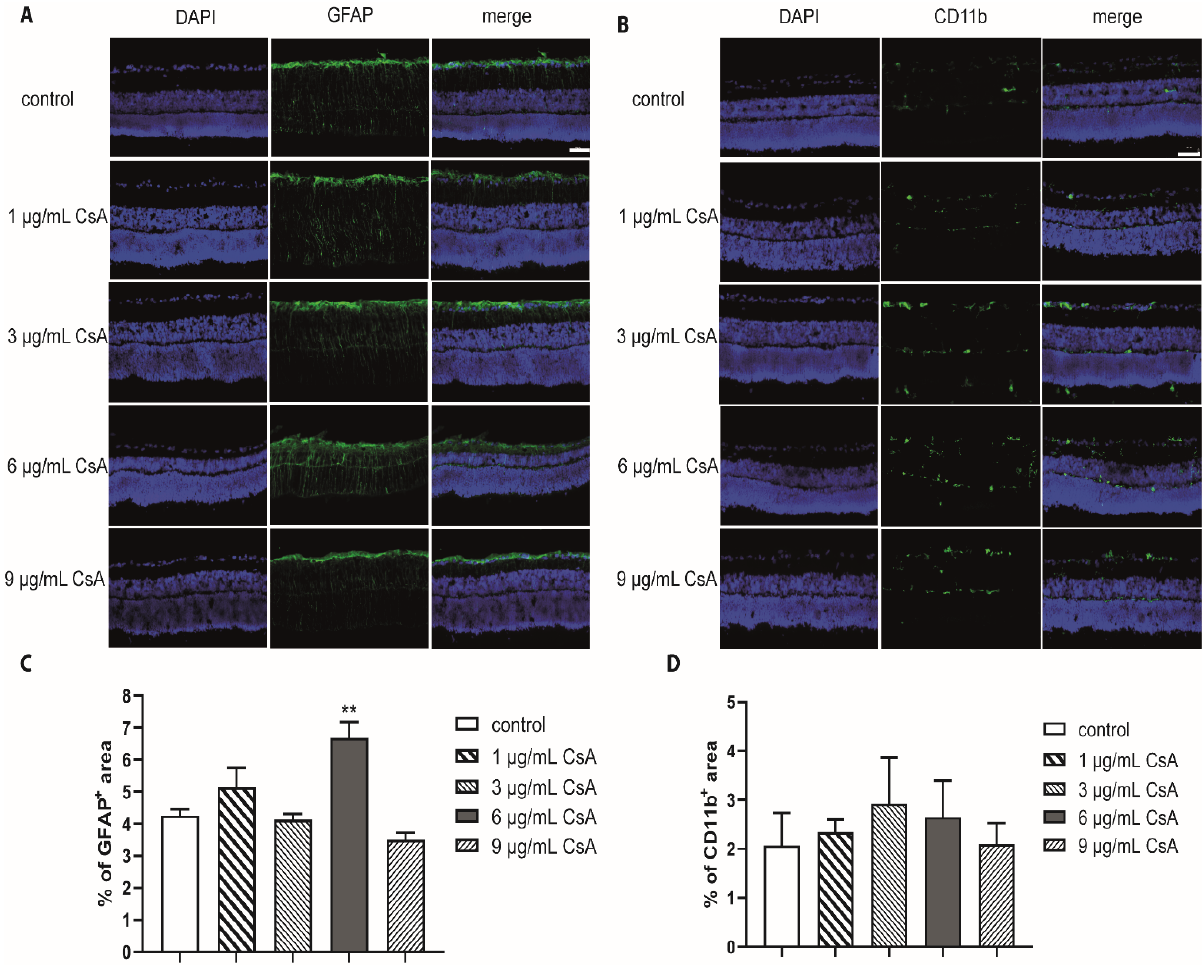
h of cultivation. Sections were double stained for DAPI and Brn3a. Bars and error bars indicate mean + SEM. (controls n = 10; all CsA groups n = 4–7).